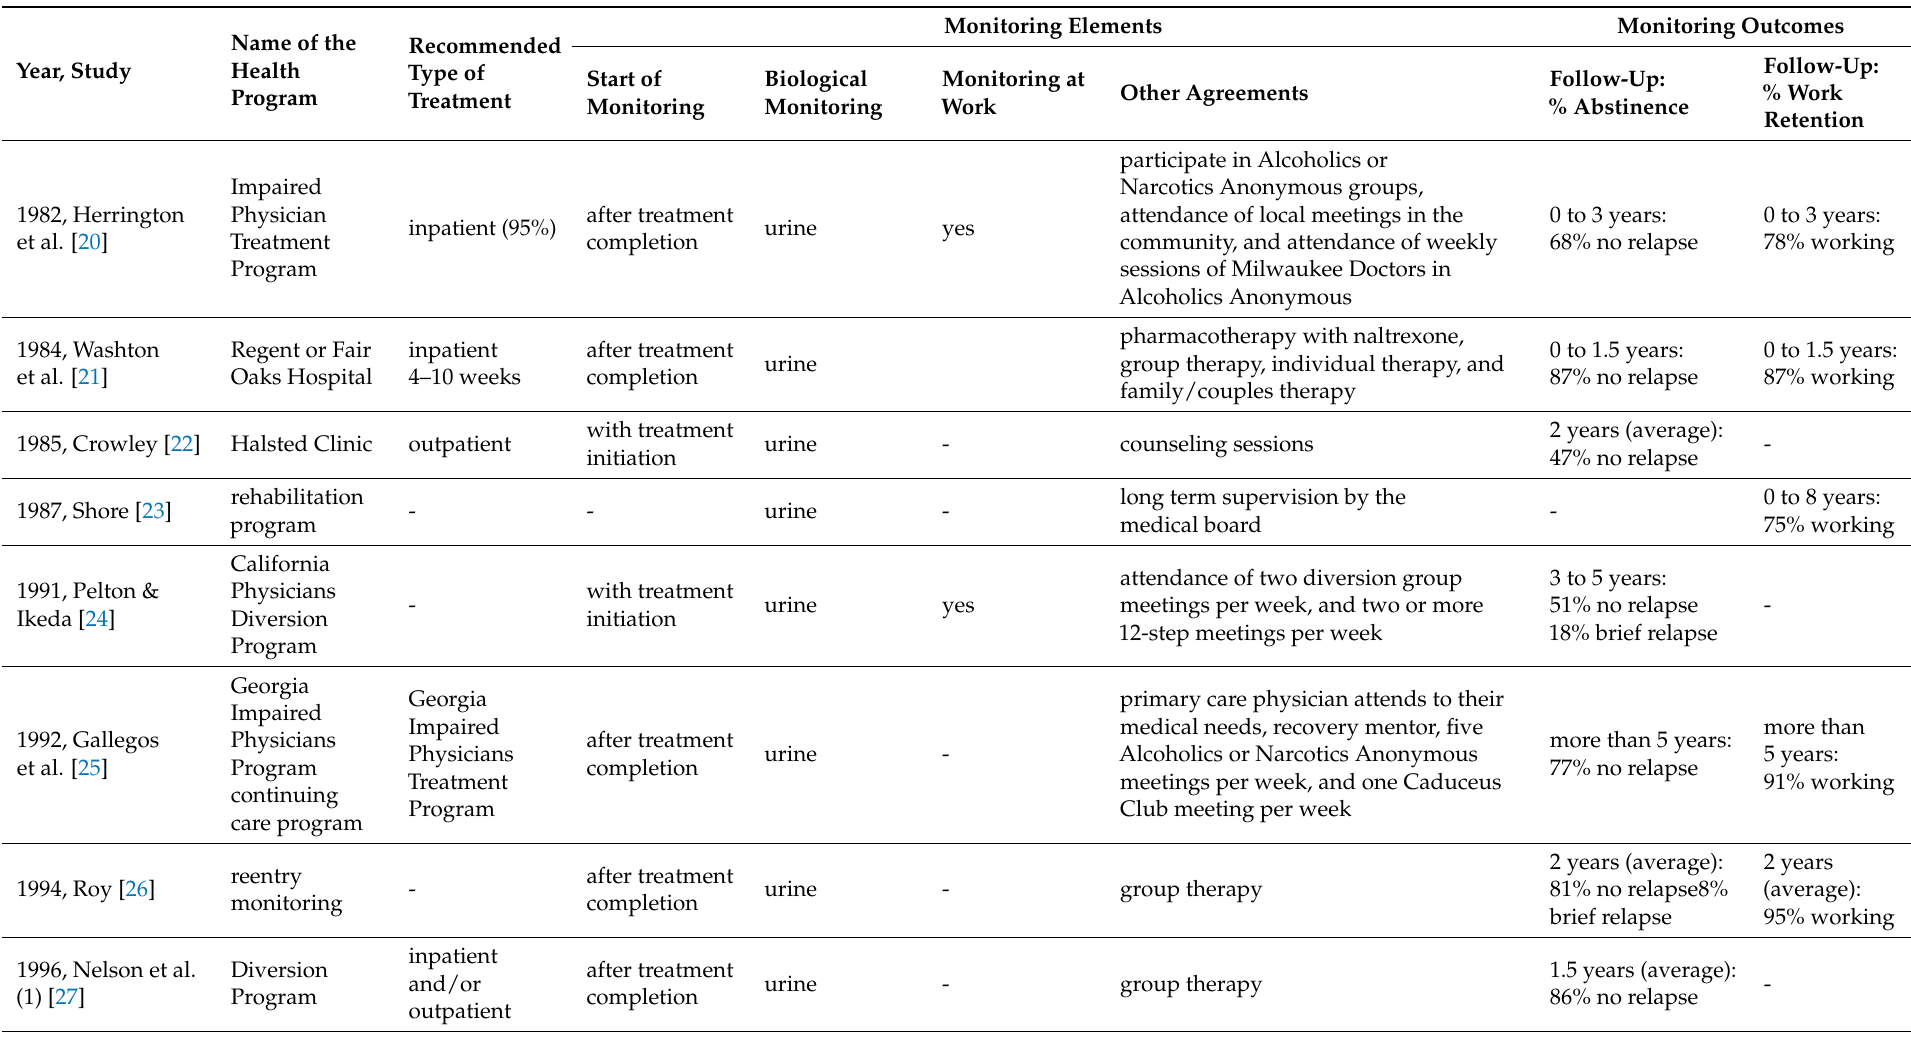
Table 3. Characteristics of